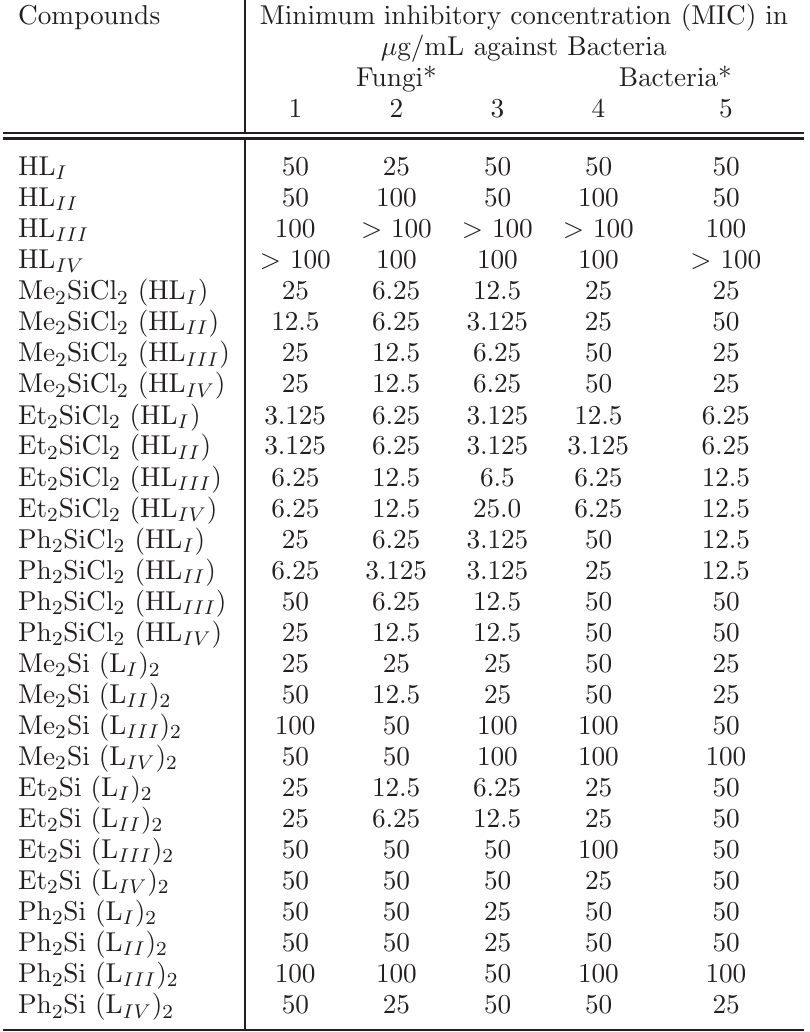
Table 3 Antimicrobial activity of ferrocenyl aroylhydrazone ligands and their complexes. Compounds Minimum inhibitory concentration (MIC) in μ g/mL against Bacteria